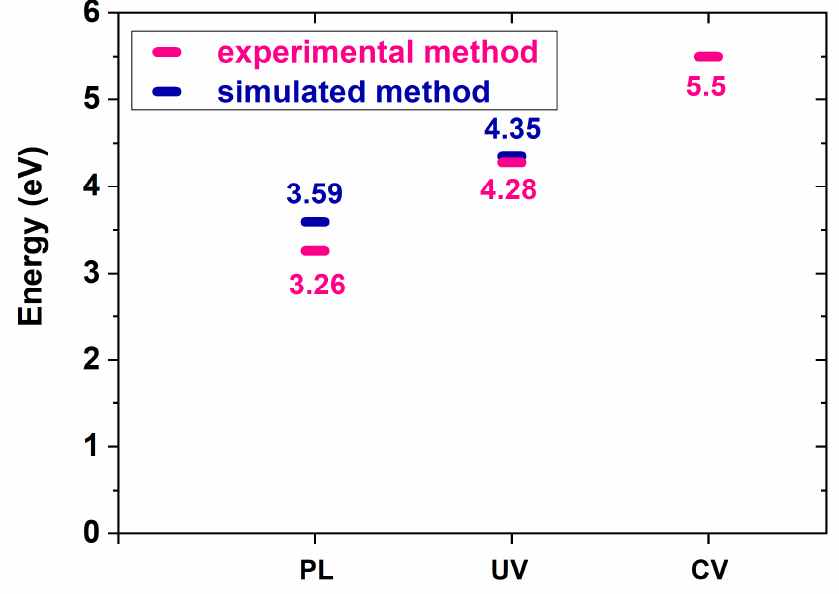
Figure 6. T2 band gaps obtained from experimental data and calculated from cyclic voltammetry readings, UV/Vis spectra, and PL spectra.